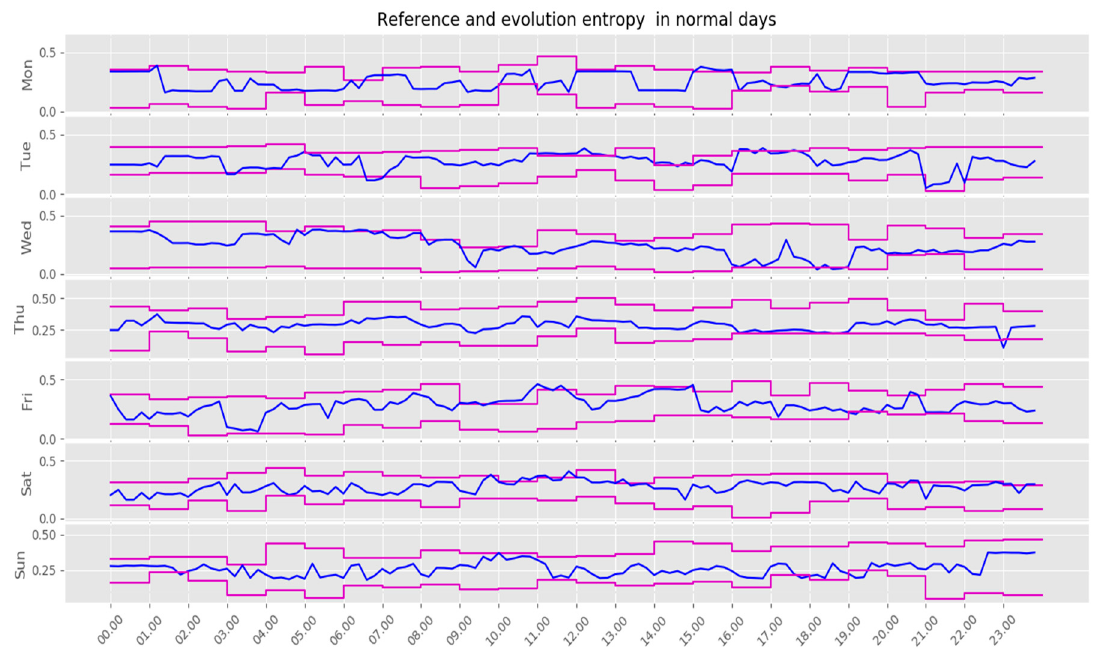
Figure 6. Reference interval of entropy; the minimum and maximum entropy value for each interval (purple) and real entropy evolution (blue) for the 7 days of the week for the time interval T = 60 min in New York City.